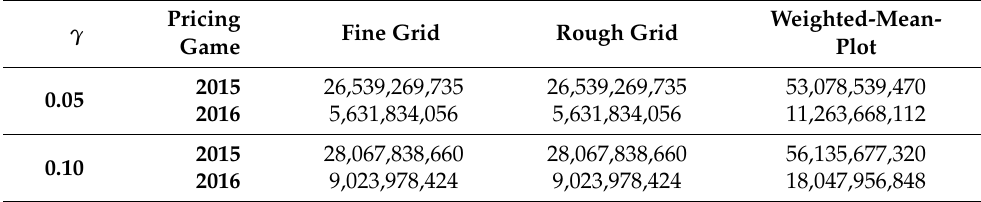
Table 3. The number of comparable pairs that are used to exactly calculate C ≈ model on the 2015 and 2016 pricing game dataset. This is done for the fine grid, rough grid and weighted-mean-plot